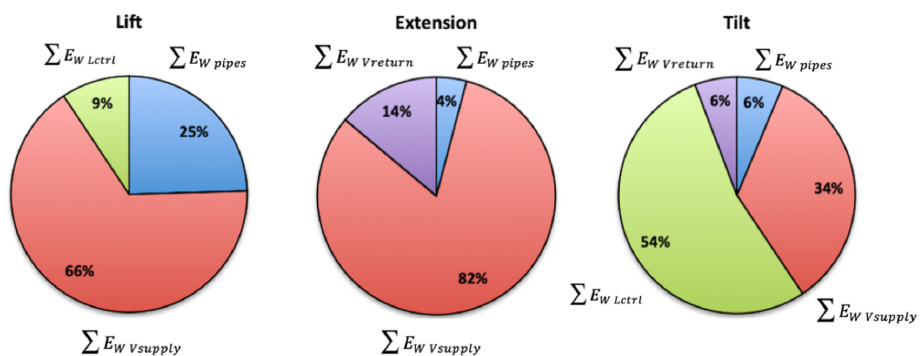
Figure 9. Distribution of hydraulic losses in the